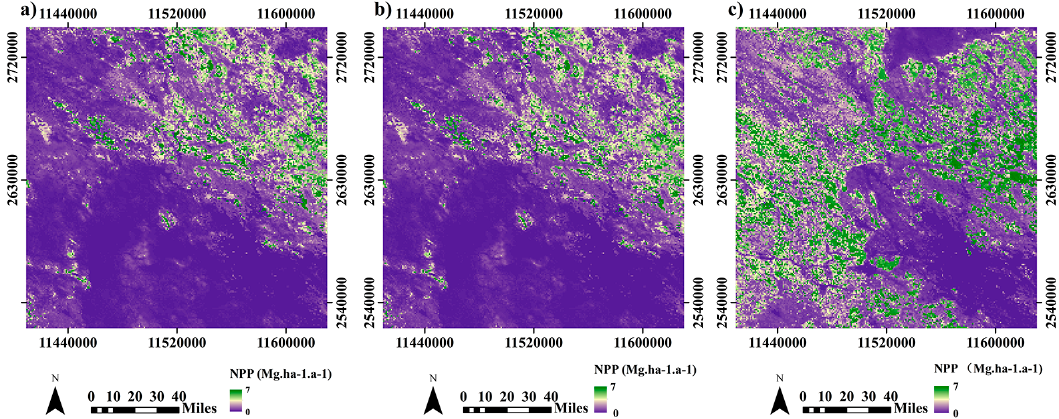
Figure 6. Comparison of spatial distributions of NPP on the 361st day from ( a ) the original MODIS-NPP ( b ) de-noised using the DWT, and ( c ) predicted using the method combining the DWT with EKF.